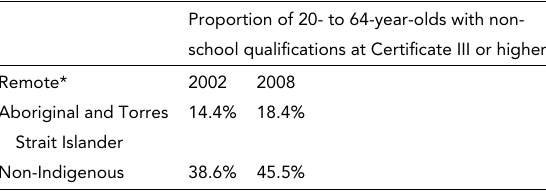
Changes in Proportion of 20- to 64-Year-Olds With Non-School Qualifications at Certificate III or Above Proportion of 20- to 64-year-olds with